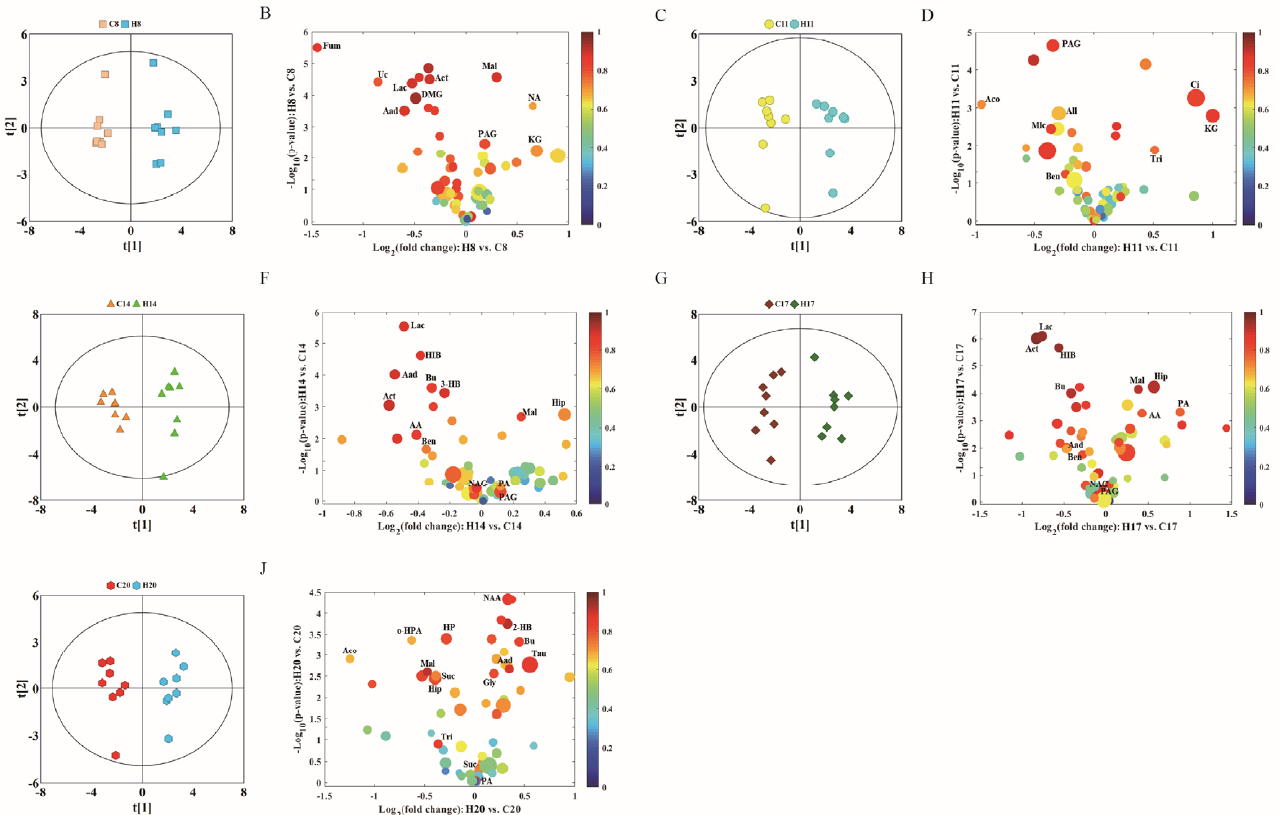
Figure 6. OPLS-DA scores plots ( left panel) derived from 1 H NMR spectra of urine samples and corresponding volcano plots ( right panels) obtained from different groups and cross validation ( lower panel) by permutation test ( n = 200). ( A , B ) D8; ( C , D ) D11; ( E , F ) D14; ( G , H ) D17; and ( I , J ) D20. The color map shows the significance of metabolite variations between the two classes. Peaks in the positive direction indicate metabolites that are more abundant in the groups in the positive direction of first principal component. Consequently, metabolites that are more abundant in the groups in the negative direction of first primary component are presented as peaks in the negative direction. Keys of the assignments are shown in Figure